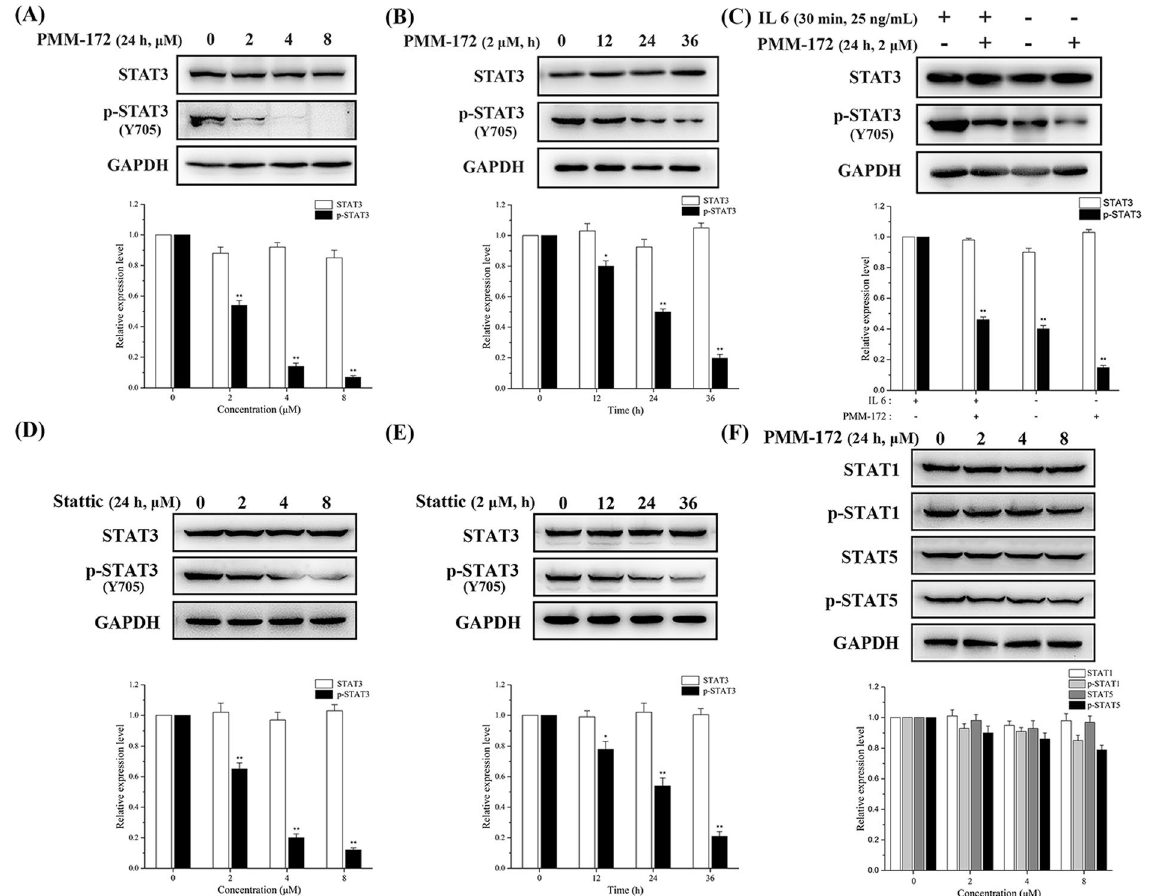
with IL-6 (20 ng/mL) or vehicle for 30 min, with or without pretreatment with PMM-172 (2 μ M) for 24 h. PMM- 172 inhibited IL-6 induced phosphorylation of STAT3. ( D ) Stattic suppressed constitutive pSTAT3 (Tyr705) in a dose-dependent manner. ( E ) Stattic suppressed constitutive pSTAT3 (Tyr705) in a time-dependent manner. ( F ) Tyrosine phosphorylation of two STAT family proteins STAT1 and STAT5 were detected with specific antibodies. PMM-172 inhibited neither the phosphorylation nor expression of STAT1 and STAT5. Data were shown as mean ± SD of three independent experiments. * P < 0.05, ** P < 0.01. Cropped blots/gels were